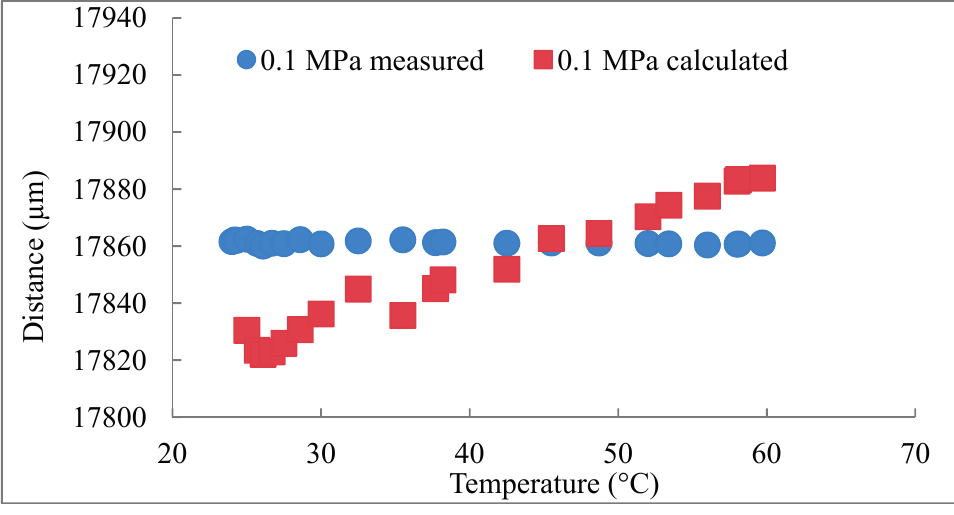
Figure 2. Experiment in 0.1 MPa pressure. σ